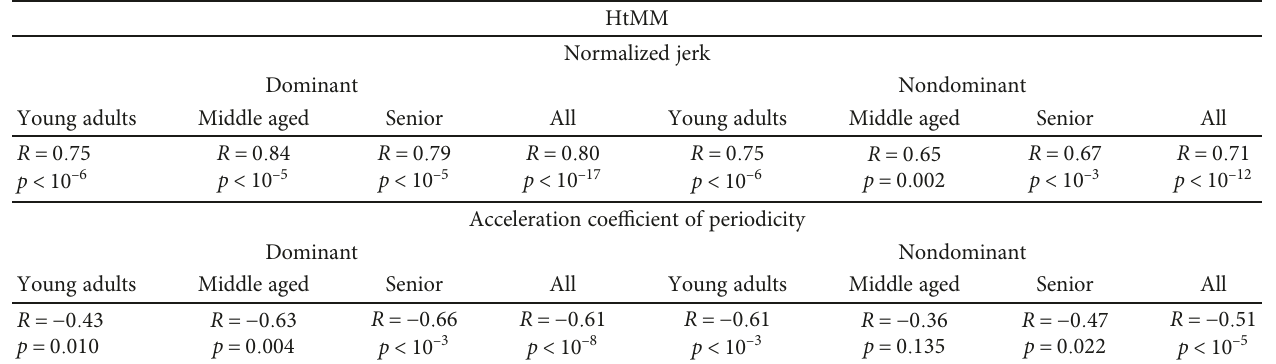
Table 8: ( T , motor control indexes) regression — hand-to-mouth